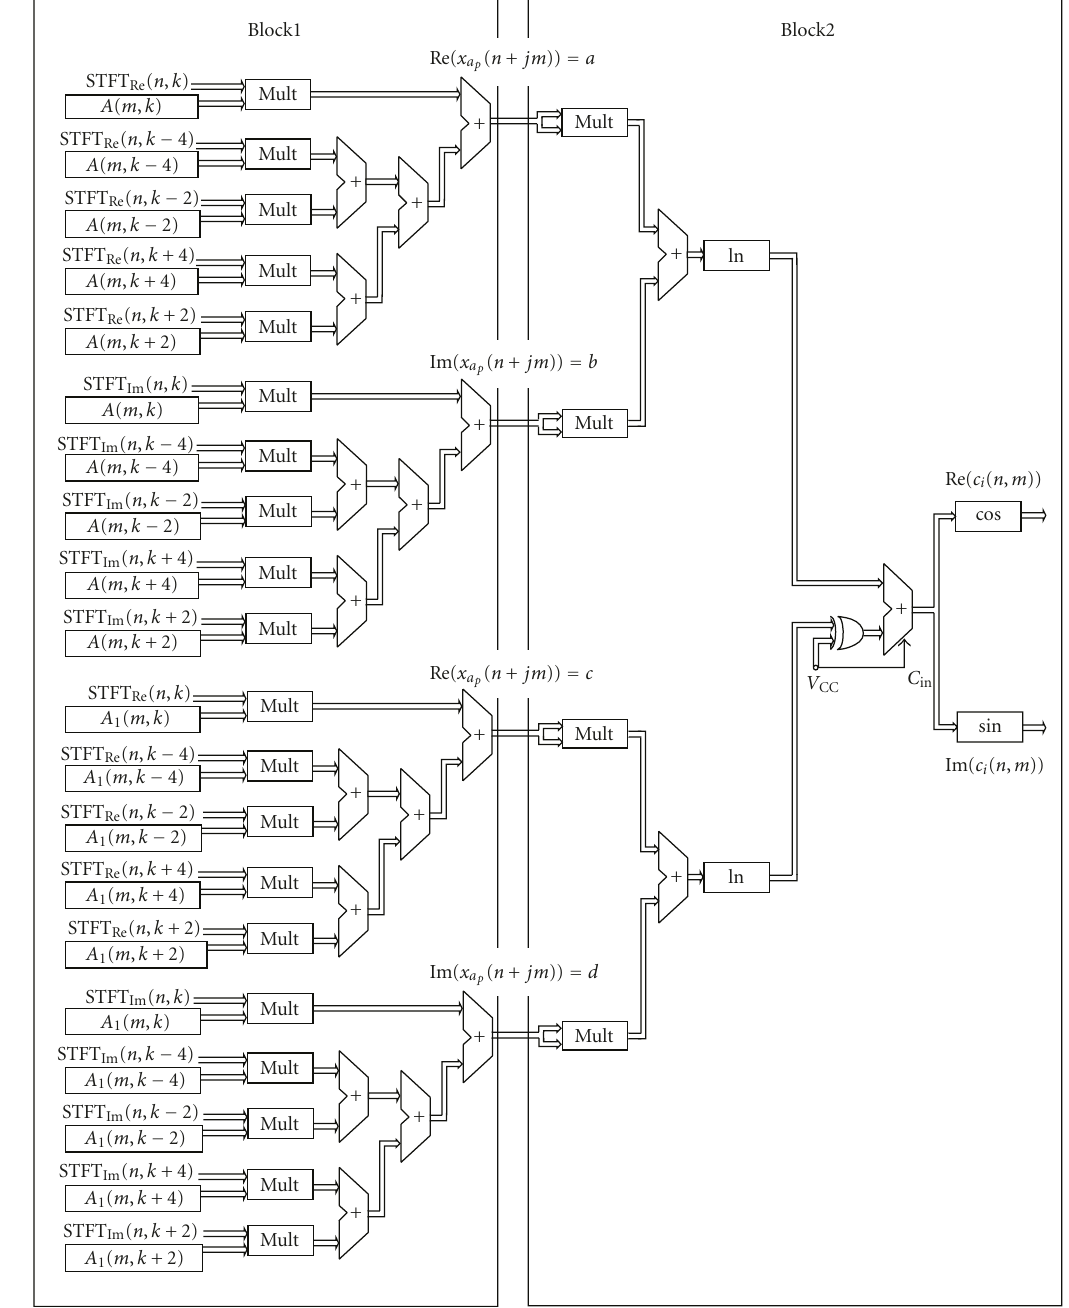
Figure 15: Architecture for concentration function